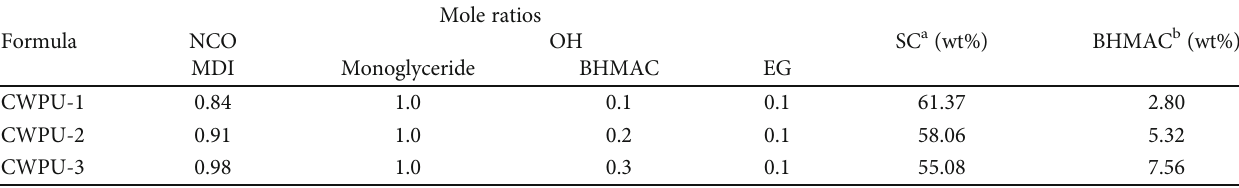
Table 1: Chemical composition of CWPUs with various internal emulsi fi er contents.